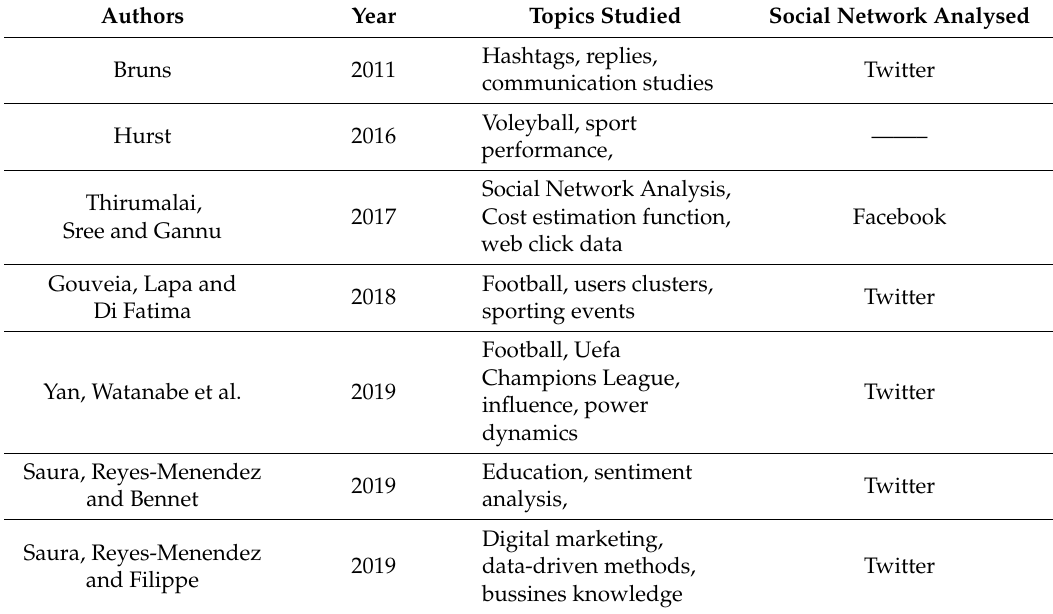
Table 1. Studies that use Gephi as software for social network analysis. Source: own